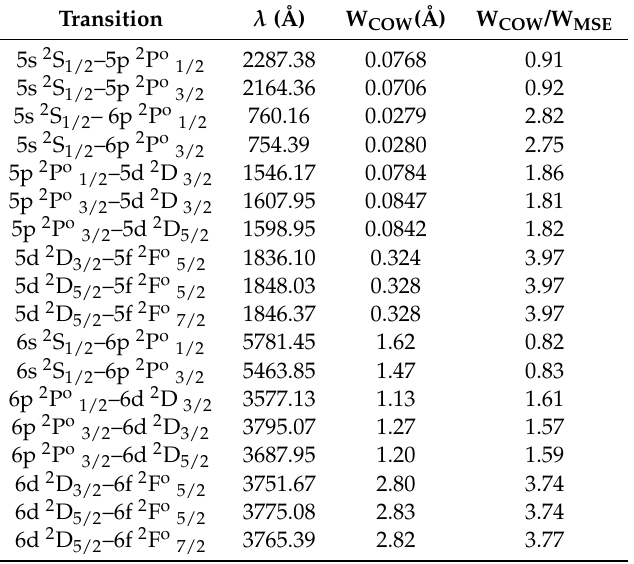
Table 1. Estimated Stark widths for 18 spectral lines of Zr IV according to Cowley (1971) using Equation (6) (W COW ) for a temperature of T = 10,000 K and electron density of N = 10 23 m − 3 . Estimated Stark widths are compared with MSE calculated Stark widths W MSE [5].